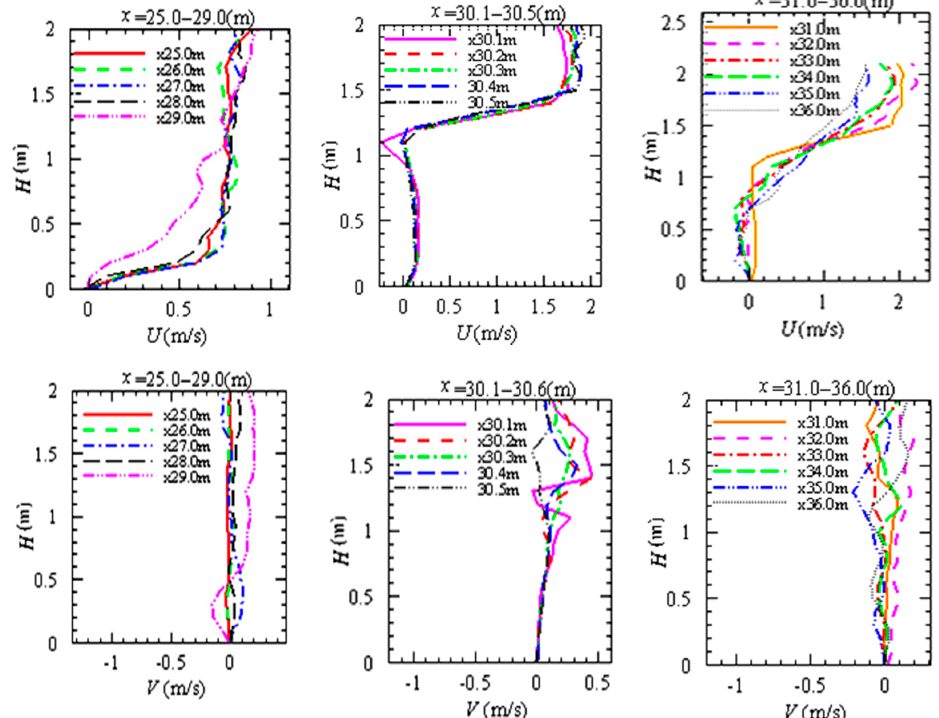
Figure 13. Characteristics of longitudinal and vertical flow fields when the vertical section of the pore is 1.2 m × 1.2 m; solid line: x = 25.0; x = 30.1 x = 31.0; dashed line: x = 26.0; x = 30.2 x = 32.0; dotted line: x = 27.0; x = 30.3x = 33.0. Long dashed line: x = 28.0; x = 30.4 x = 34.0; double dotted line: x = 29.0; x = 30.5 x = 35.0; dotted line: x = 36.0.